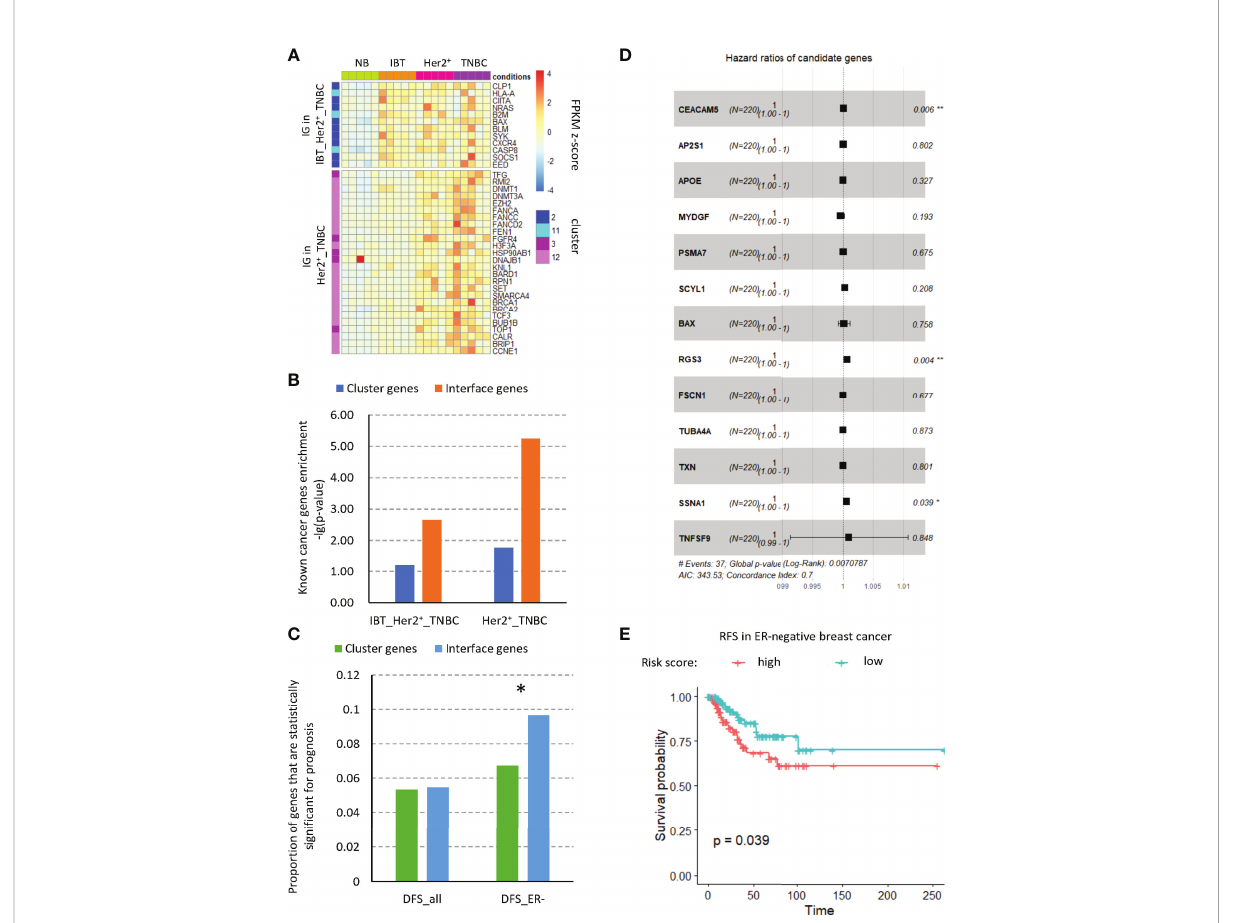
FIGURE 4 Interface genes were enriched in cancer-related genes. (A) The expression of known tumor-related genes in interface genes from IBT_Her2 + _TNBC module and Her2 + _TNBC module. (B) Enrichment of known tumor-related genes in different modules. (C) Proportion of genes with prognostic signi fi cance. Cluster, genes in clusters 2, 11, 3, and 12; IG, interface genes; DFS, disease-free survival; all, all breast cancer types; ER − , ER-negative breast cancer. (D) Forest plot of the hazard ratio (HR) for the association of risk factor gene expression with DFS. (E) Disease-free survival curves of high- and low-risk score groups based on multivariate Cox regression analysis. *, p-value < 0.05; “ ** ” , p-value <